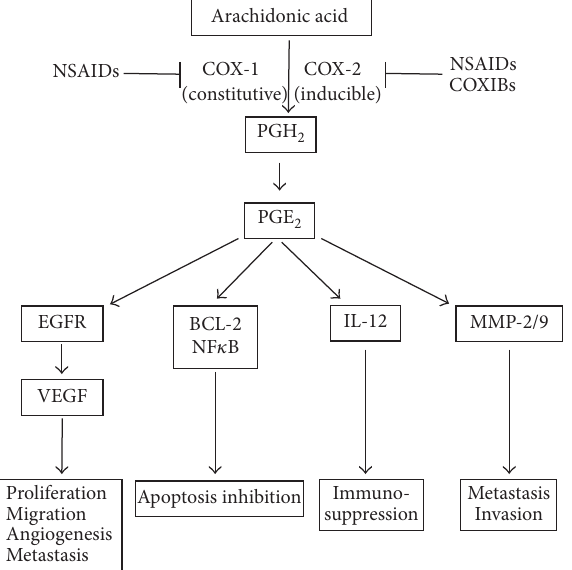
Figure 1: Prostaglandin E2 biosynthesis and downstream cellular effects. Arachidonic acid is released from cellular membranes and converted to PGH 2 through the activity of the COX enzymes. COX- 1 is constitutively expressed in many cells, generating low levels of prostaglandins that are cytoprotective and maintain homeostasis. In contrast, COX-2 is absent from most cells and is induced by a number of inflammatory stimuli. PGH 2 is rapidly converted to PGE 2 , which plays a predominant role in cancer progression by stimulating tumour cell proliferation, migration, angiogenesis, apoptosis resistance, invasion, and metastasis. NSAIDS and COX- IBS can pharmacologically block the activity of the COX